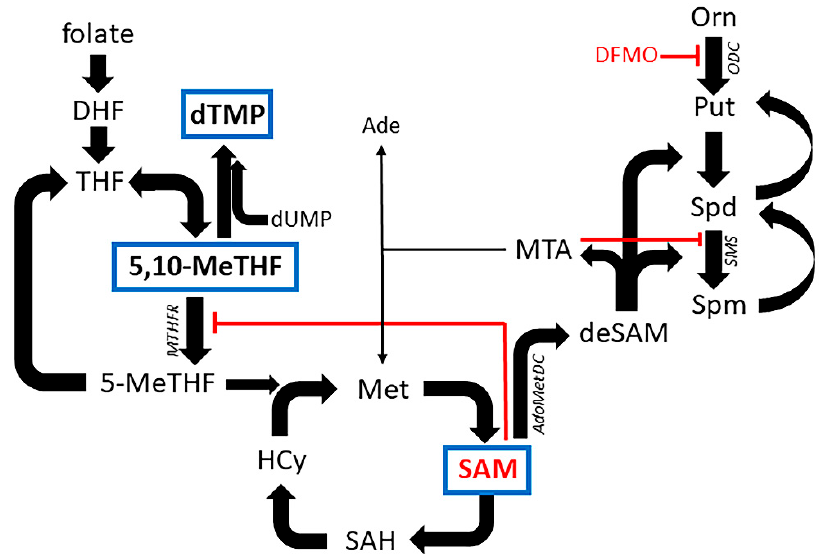
Figure 1. Metabolic pathways connecting folate, L -methionine and polyamine cycles. 5,10-MeTHF,